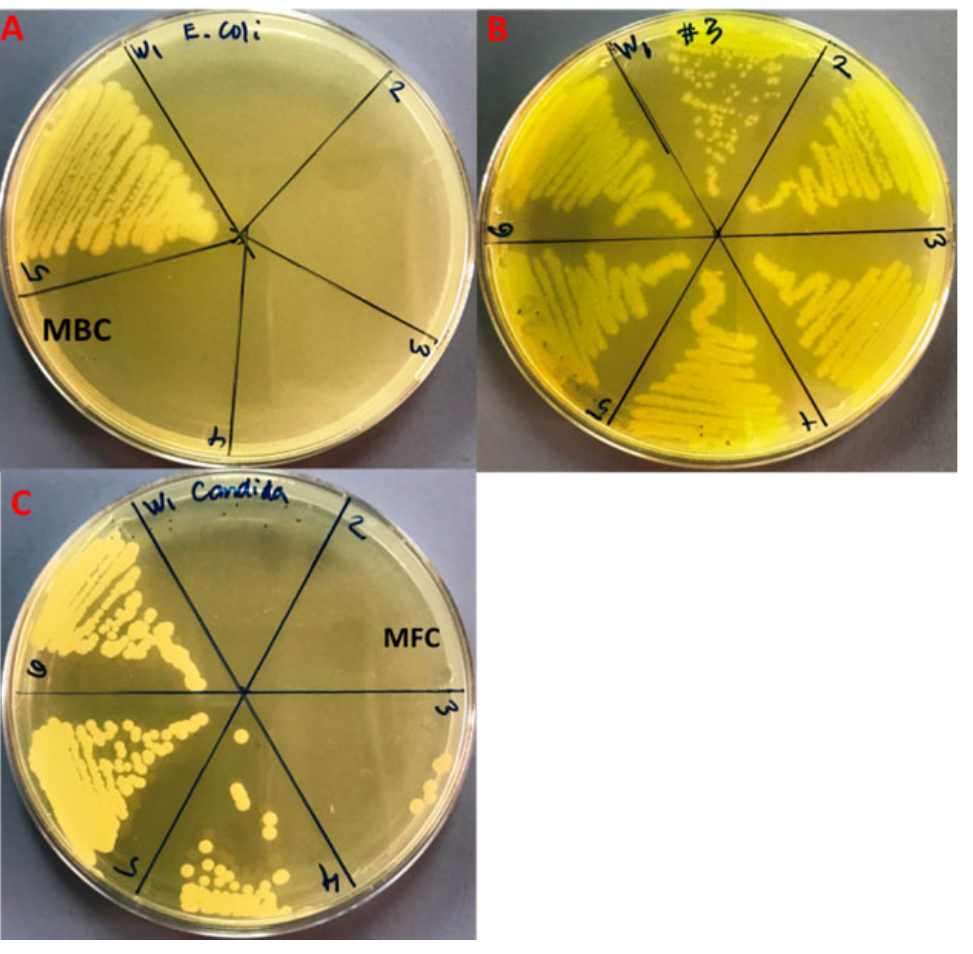
Figure 7. MBC/MFC (mg/mL) results of fenchone oil against E. coli ( A ), MDR ‐ PA ( B ) and C. albicans ( C ). The dosage of fenchone oil is numerically depicted as 1, 2, 3, 4, 5 and 6, which are 200, 100, 50, 25, 12.5 and 6.25 mg/mL, respectively. Table 4. MIC and MBC (mg/mL) values of Fenchone against tested